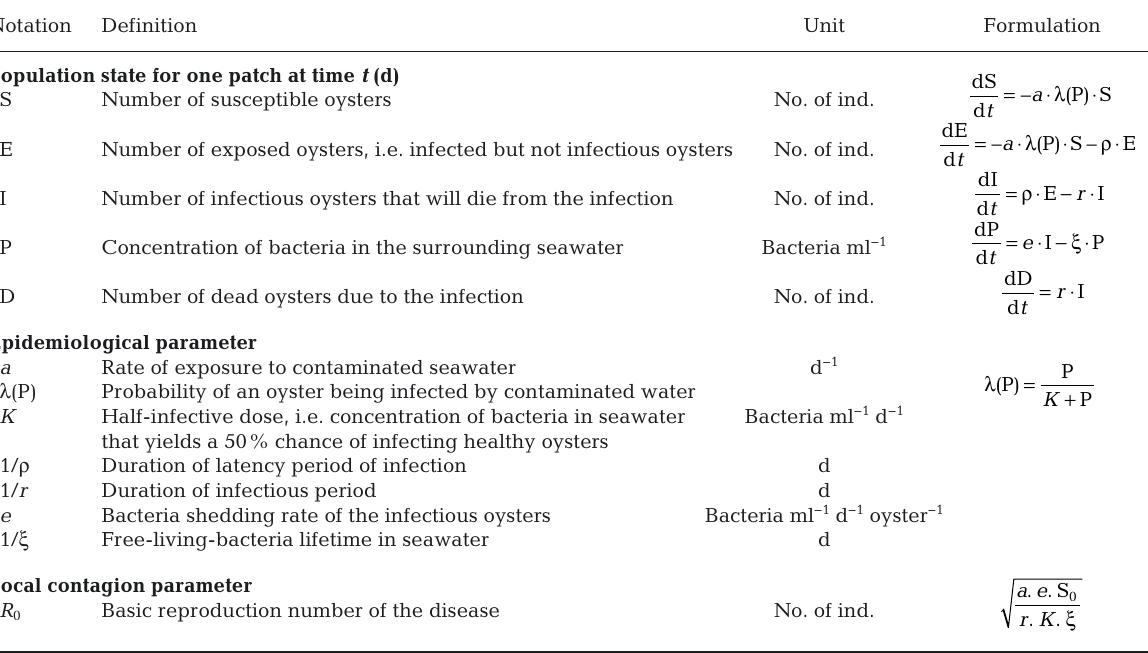
Table 1. Variables and